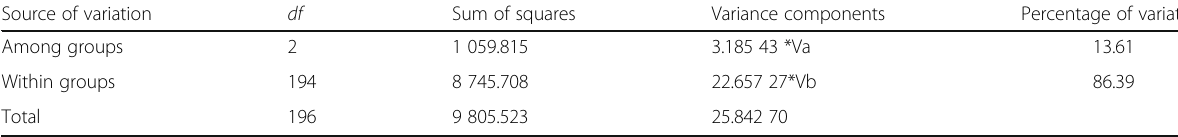
Table 3 Analysis of molecular variance for Gossypium arboreum accessions among and within three groups corresponding to three major regions of Gossypium arboreum growing in China as identified by STRUCTURE Source of variation df Sum of squares Variance components Percentage of variation Among groups 2 Within